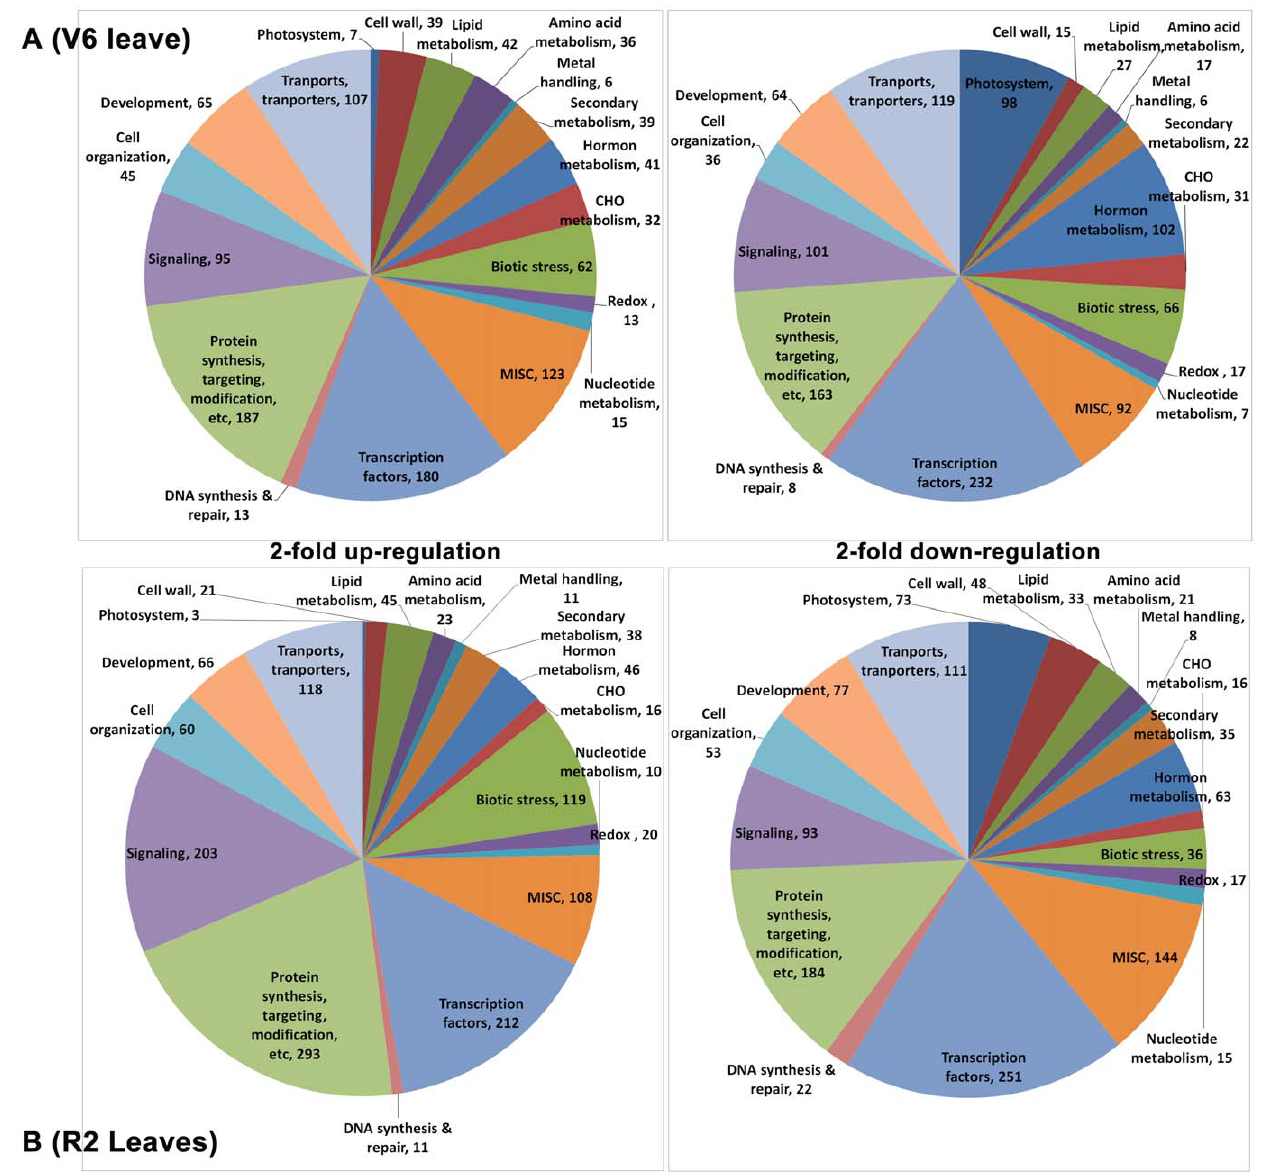
Figure 2. Distribution of up- and down-regulated genes into major biological processes. MapMan was used to classify the genes into the functional categories. Gene numbers are displayed next to the terms.